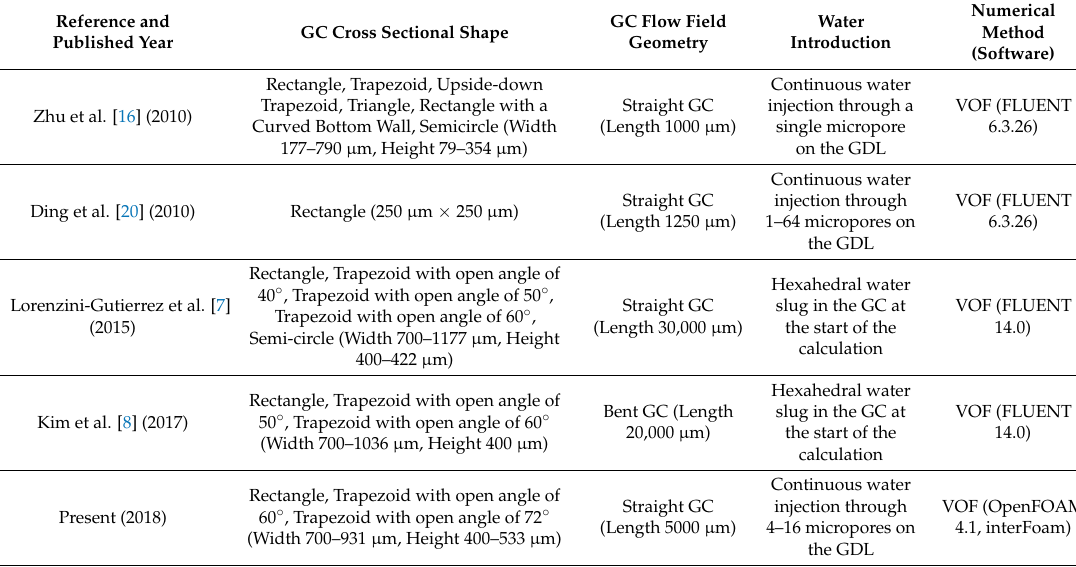
Table 1. Numerical studies on the effect of gas channel (GC) cross-sectional shape on gas-liquid two-phase flow in polymer electrolyte membrane (PEM) fuel